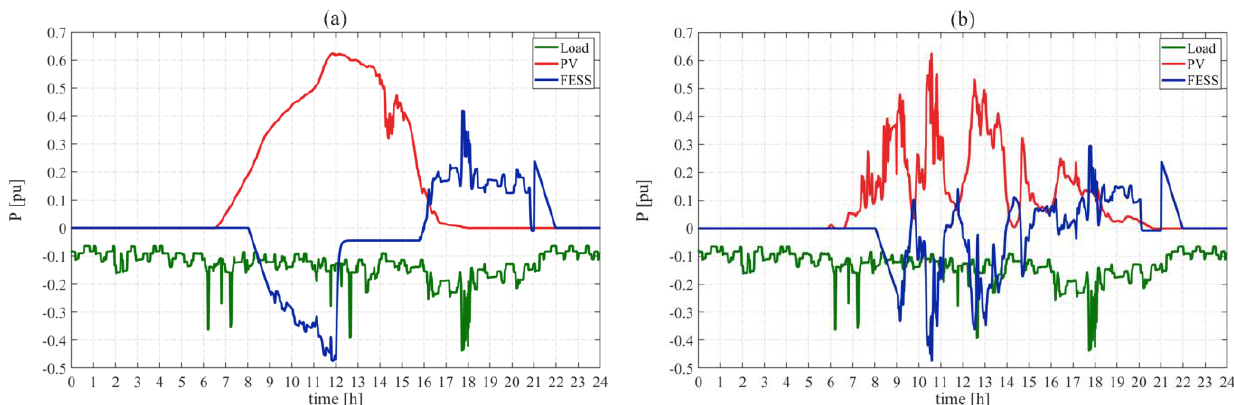
Figure 13. Load, PV, and FESS grid powers achieved over a real operating scenario @720 V: cases C1 ( a ) and C2 ( b ).